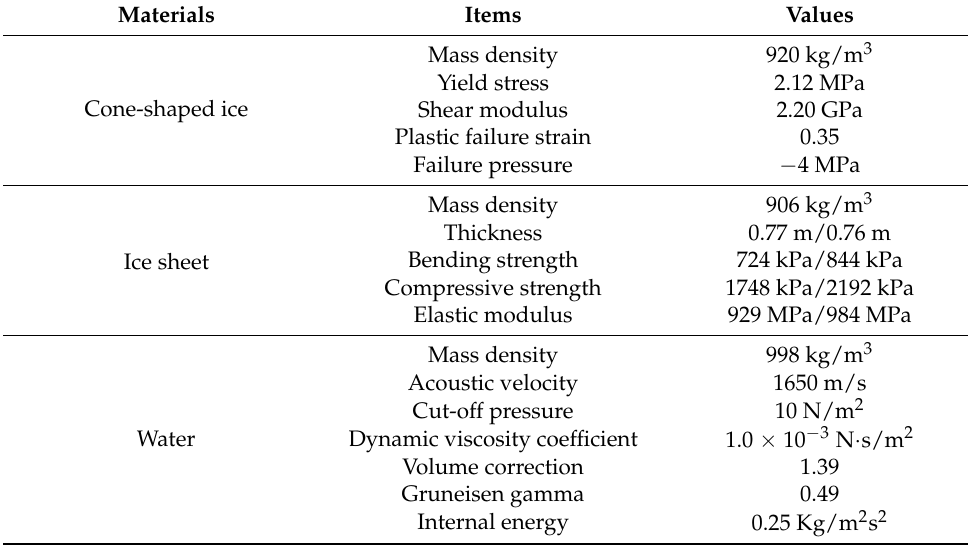
Table 1. The parameters used in the numerical